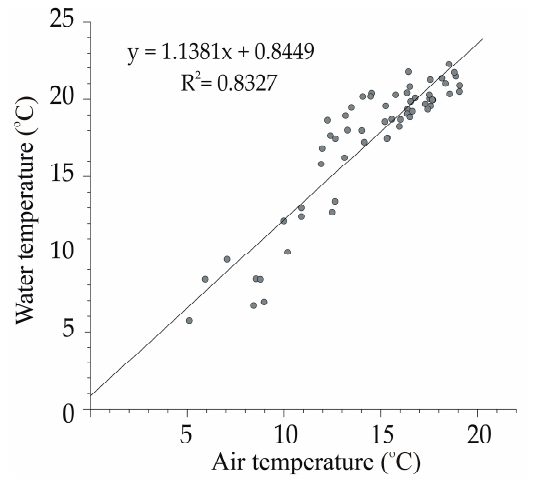
Figure 6. Correlation between average monthly air temperatures and average monthly water temperatures. Correlation is statistically significant at a level of p < 0.001. Gray points are individual months; black points are individual months from June to August. The regression between average monthly air temperature and average monthly water temperature is shown at the solid line.